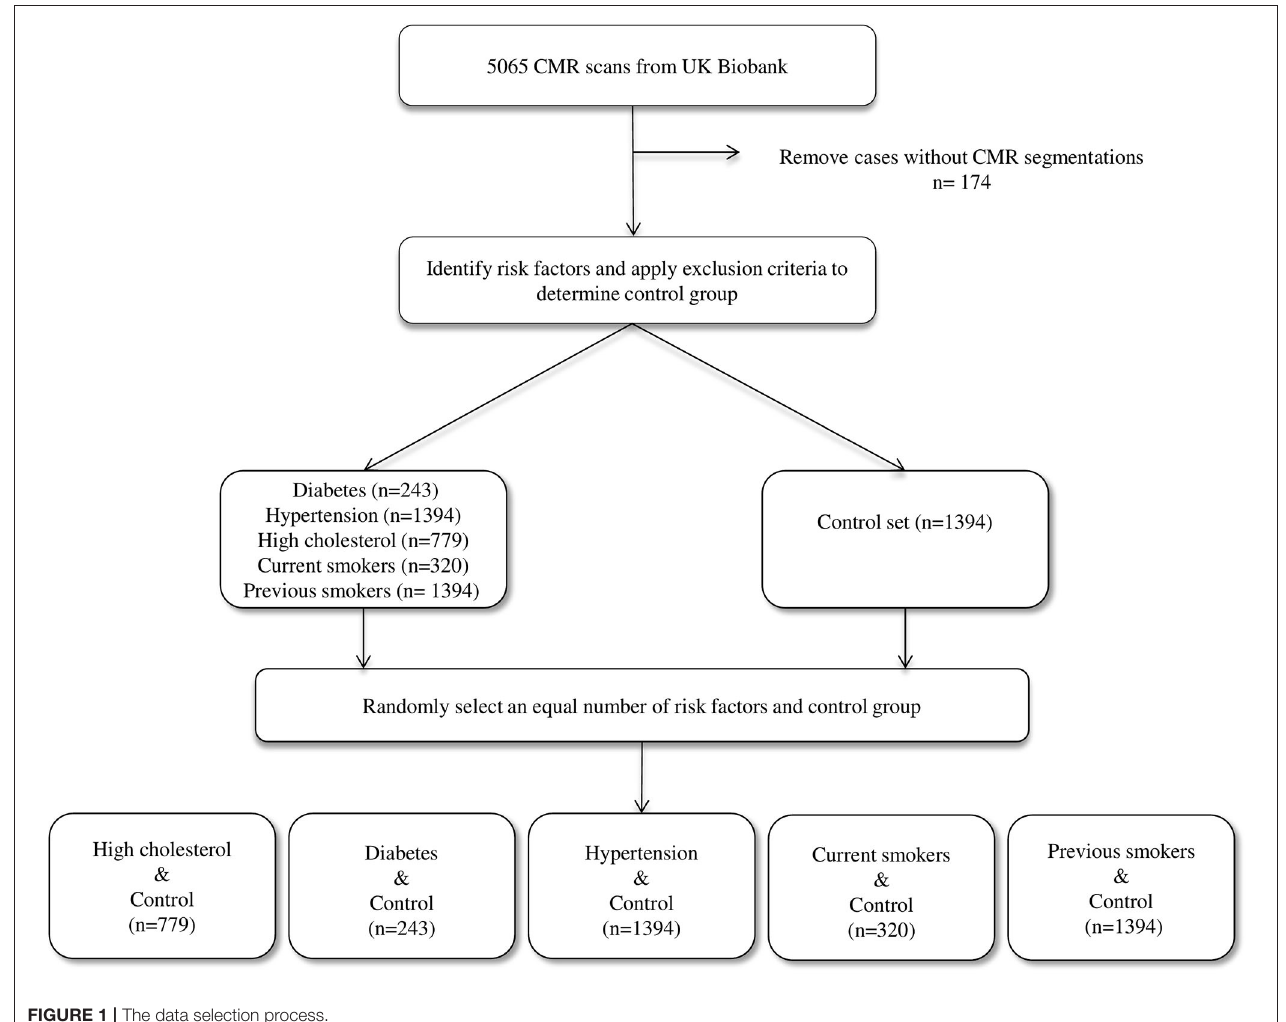
FIGURE 1 | The data selection